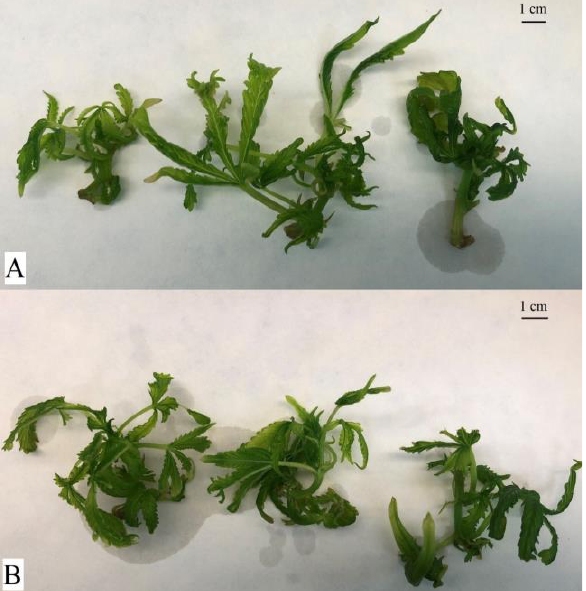
Figure 3. Comparison of experimental variants of the cultivar ‘Tatanka Pure CBD’ after 4 weeks of cultivation in Erlenmeyer flasks. Plant material at harvest before freezing with liquid nitrogen. The top shows the control variant ( A ). The bottom shows the experimental variant with the addition of PEO-IAA in the nutrient medium ( B ). The morphological differences between the variants are less visible in this cultivar than in the case of the ‘USO-31’ cultivar.